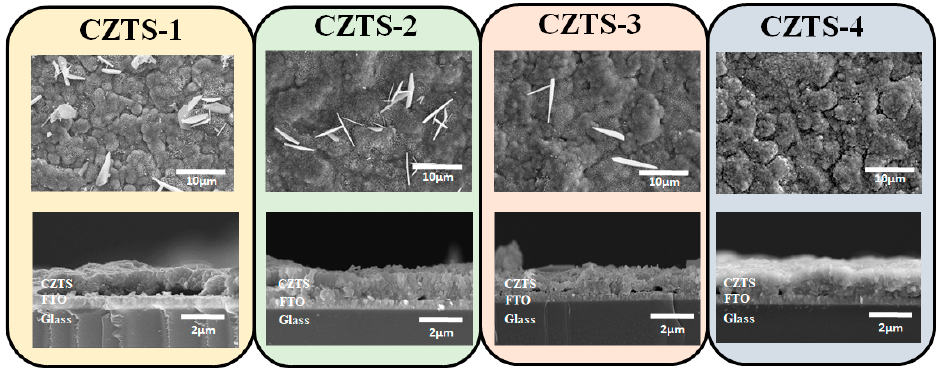
Table 1. Atomic percentages of CZTS − 1, CZTS − 2, CZTS − 3, and CZTS − 4.